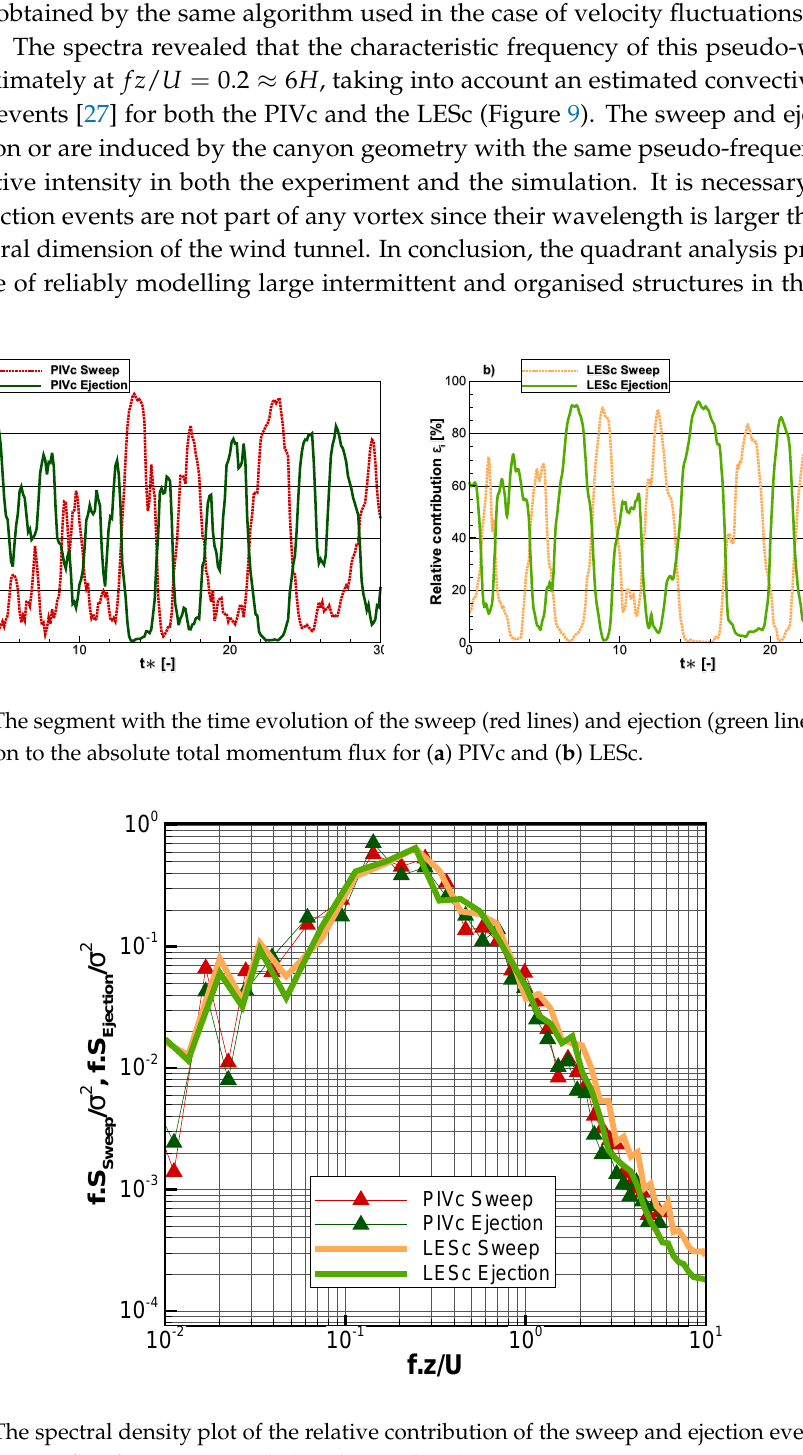
Figure 9. The spectral density plot of the relative contribution of the sweep and ejection events to the total momentum flux for PIVc (triangles) and LESc